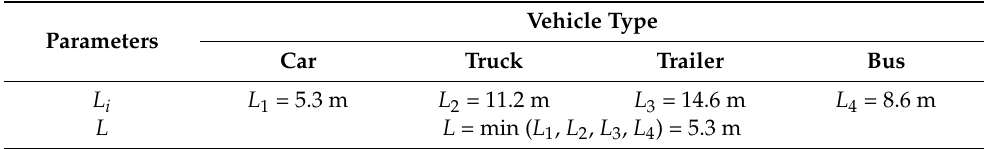
Table 8. Disturbance characteristic test of the